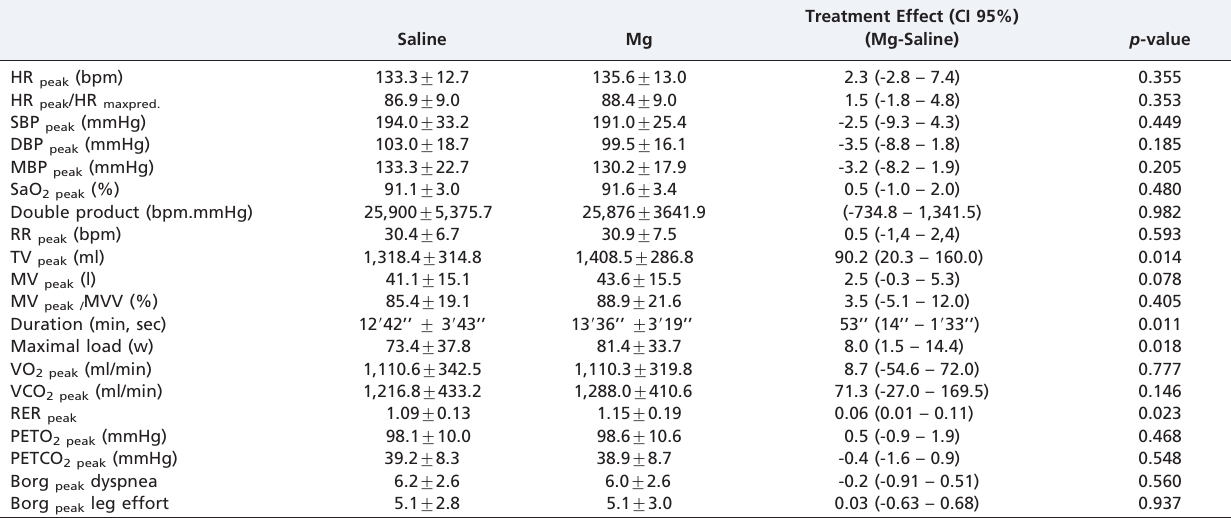
Table 4 - Effects of Mg loading on the cardiorespiratory parameters of 20 COPD patients at maximal exercise*.